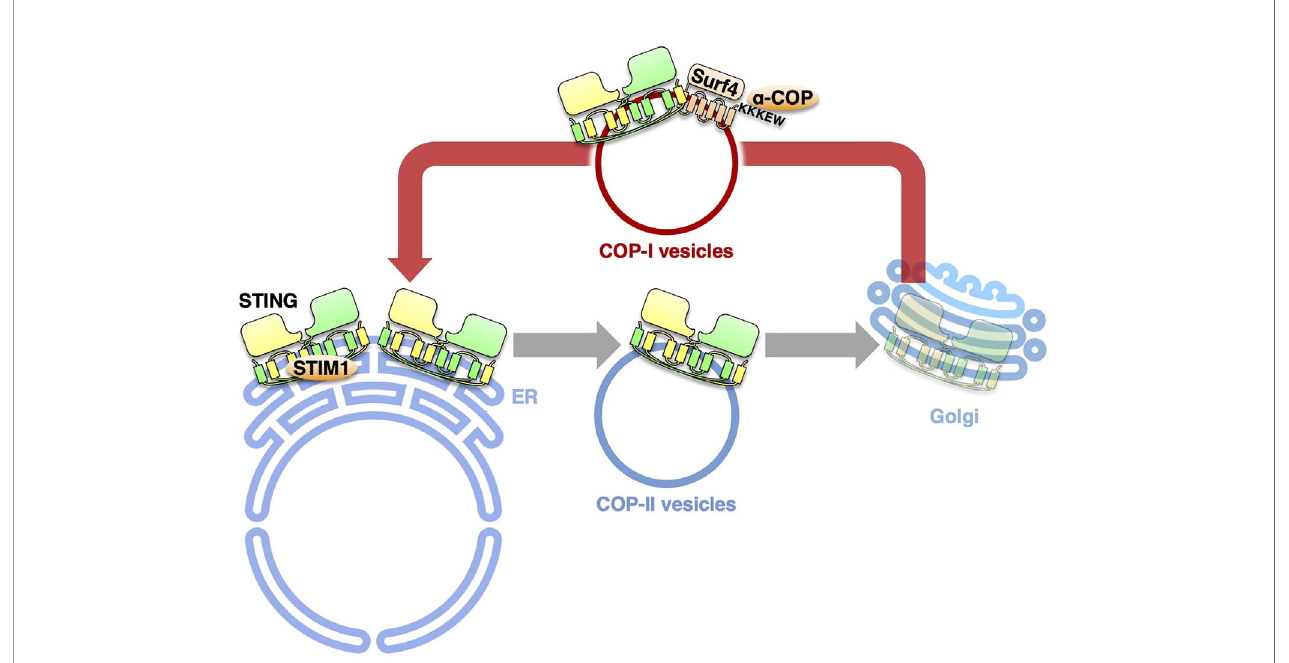
FIGURE 2 | The retrograde membrane traf fi c retrieves STING from the Golgi to the ER. The retrograde membrane traf fi c from the Golgi to the ER, which is mediated by COP-I vesicles, suppresses STING activation, by preventing STING from reaching the TGN. Surf4 functions as an adaptor to link STING and a -COP. STIM1 serves as a tether to retain STING at the